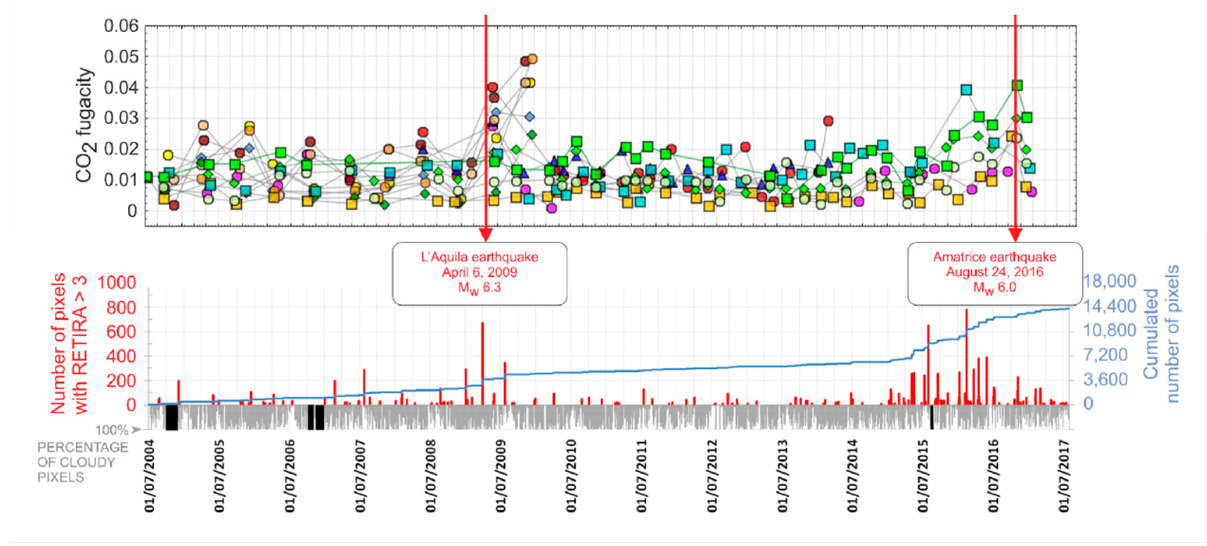
Figure 3. Tectonic-related anomalous values of CO 2 fugacity in water samples from the environmental protection agency (ARTA) network in Abruzzo (upper box), compared with thermal infrared radiation (TIR) anomalies from satellite data (lower box) (after [45]).